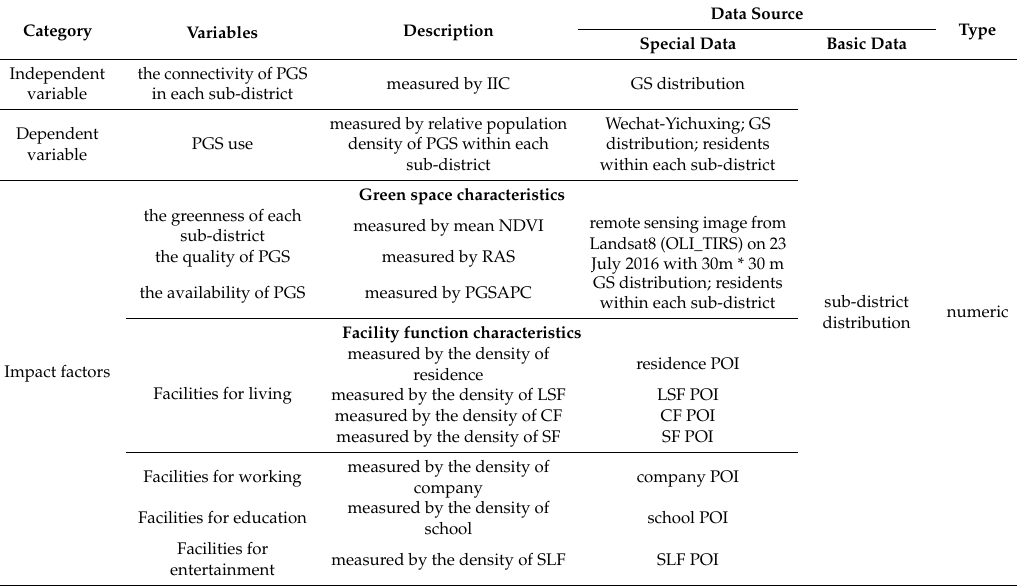
Table 1. The variables and the requisite